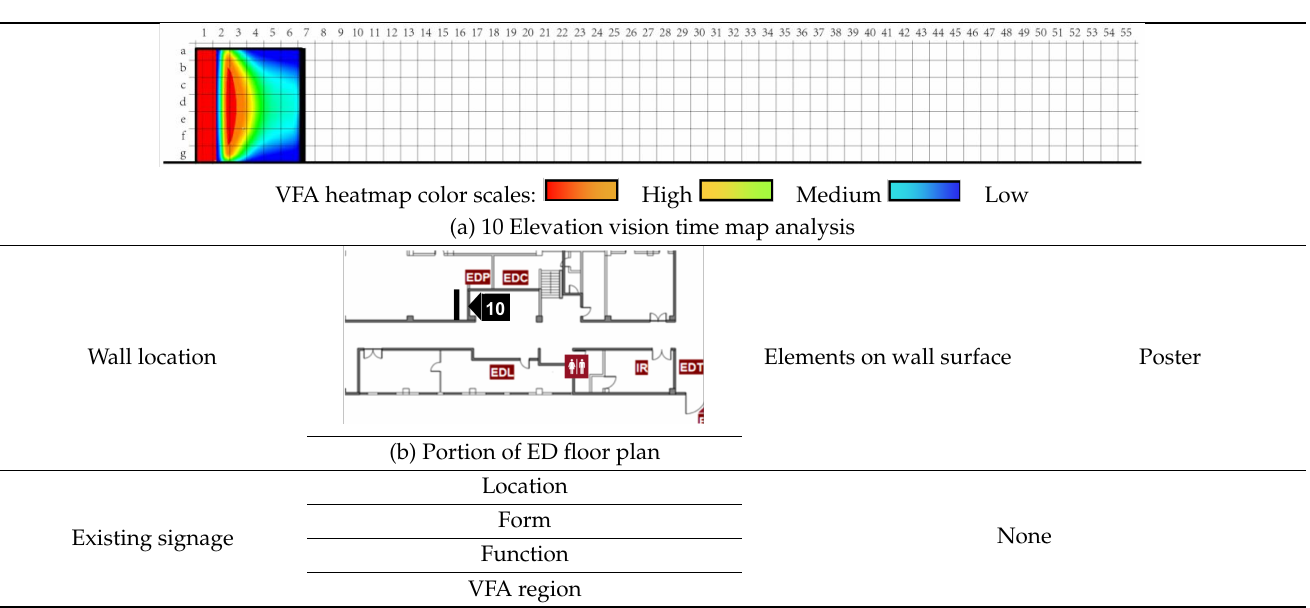
Table 14. 10 Elevation comparative